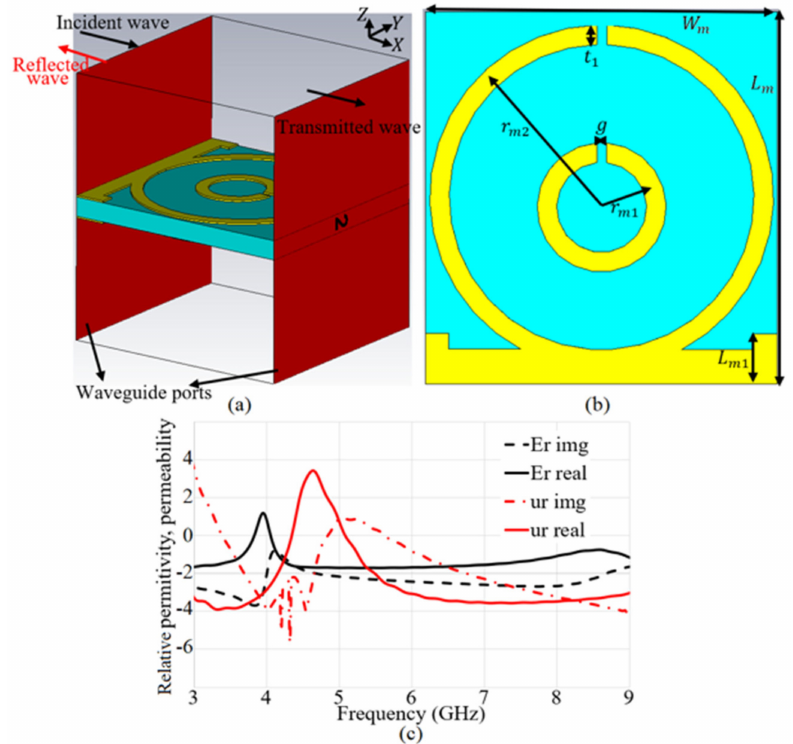
Figure 11. Metamaterials (MTM) structure’s parameters and permittivity/permeability results: ( a ) 3D view of MTM structure, ( b ) 2D view, ( c ) relative permittivity (E r ) and permeability (u r